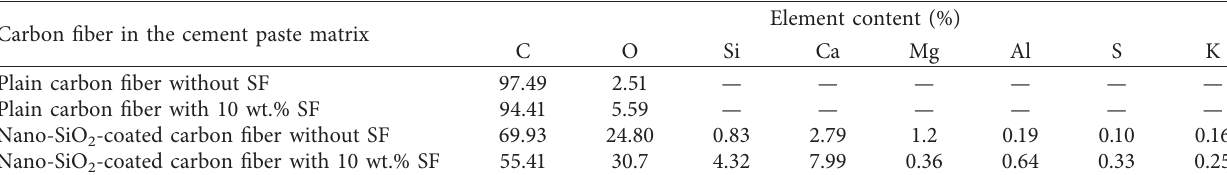
Table 4: Element analysis results of the carbon fiber